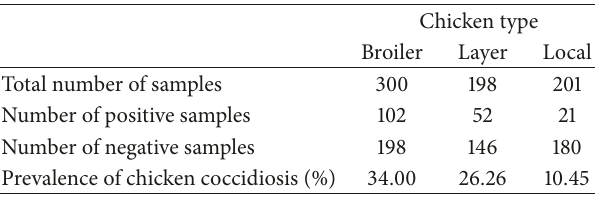
Table1:PrevalenceofchickencoccidiosisinCentralJavabychicken type.